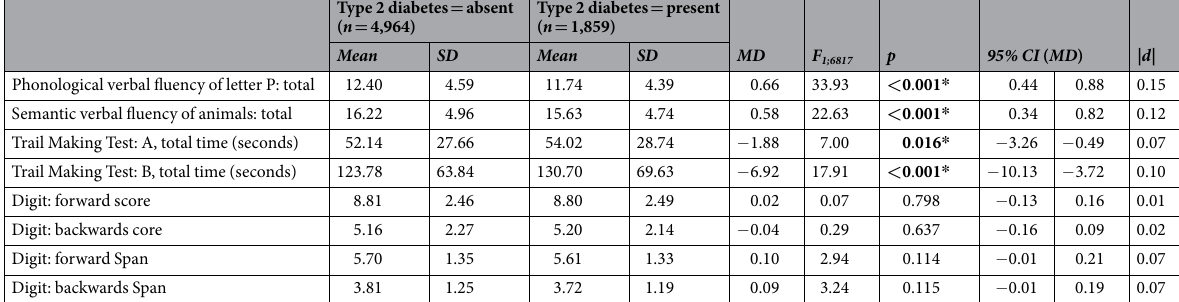
Table 2. Comparison of the cognitive assessment variables between patients with and without reported type 2 diabetes. Note . SD, standard deviation; MD, mean difference; | d |, Cohen’s- d measuring effect size. * Bold: significant comparison (0.05 level, including Finner’s correction). All the results adjusted for sex, age, education and presence of apnoea.